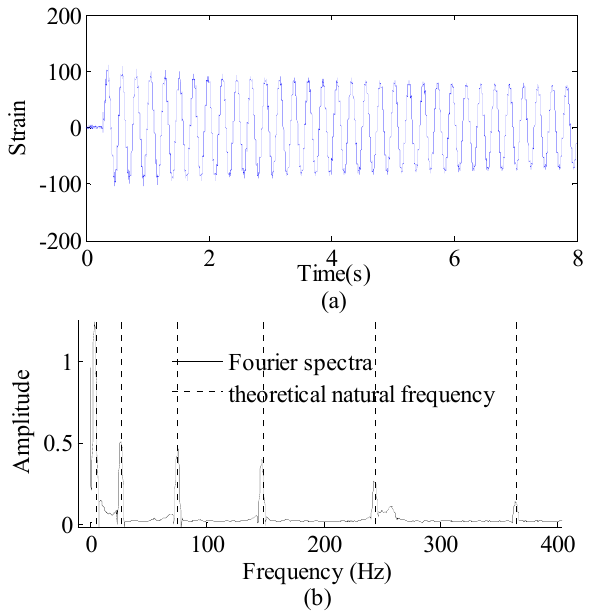
Figure 15. Strain sensor measurement data and Fourier spectra of the data. ( a ) strain sensor measurement data (0~8 s), and ( b ) Fourier spectra of the measurement data (0~8